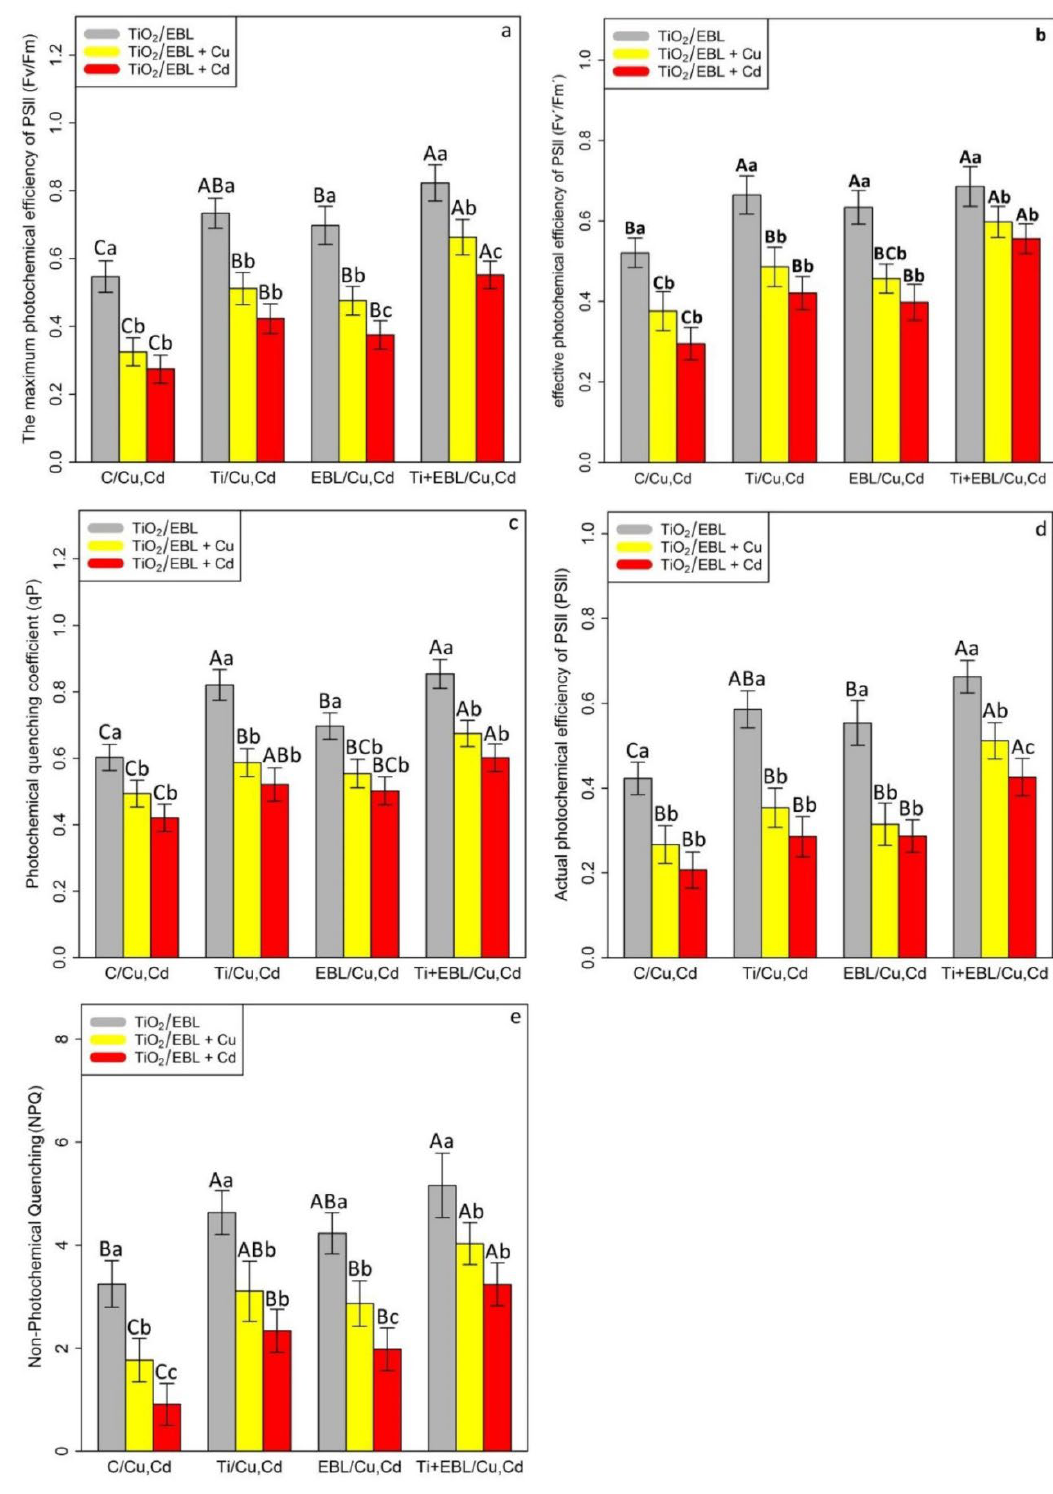
Figure 4. The effect of the co-application of 24-epibrassinolide and titanium oxide nanoparticles individually and combined on fluorescence parameters, including the maximum photochemical efficiency of PSll (Fv/Fm) ( a ), effective photochemical efficiency of PSll (Fv ′ /Fm ′ ) ( b ), photochemical quenching coefficient (qP) ( c ), actual photochemical efficiency of PSll ( ϕ PSll) ( d ), and nonphotochemical